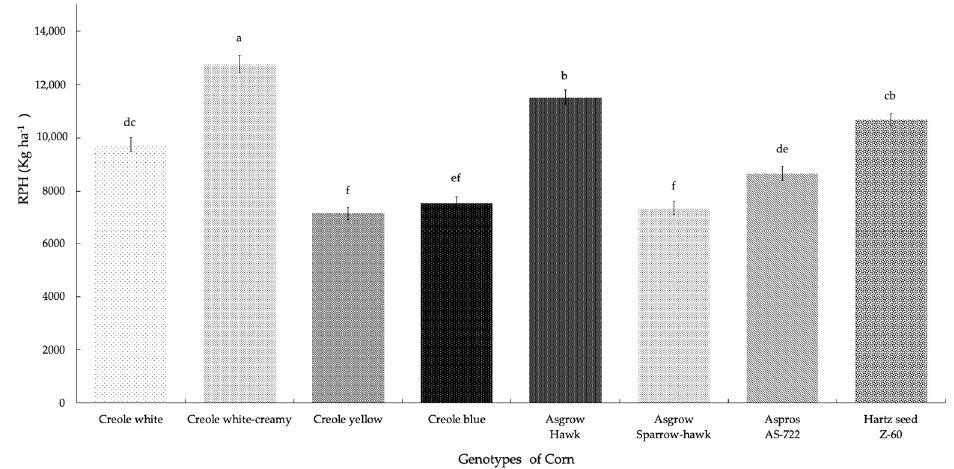
Figure 4. Potential yield (Kg ha − 1 ) of huitlacoche for each genotype of corn in Nopalucan, Puebla, Mexico. Means followed by the same letter are not significantly different ( p ≤ 0.05) according to Tukey’s test.